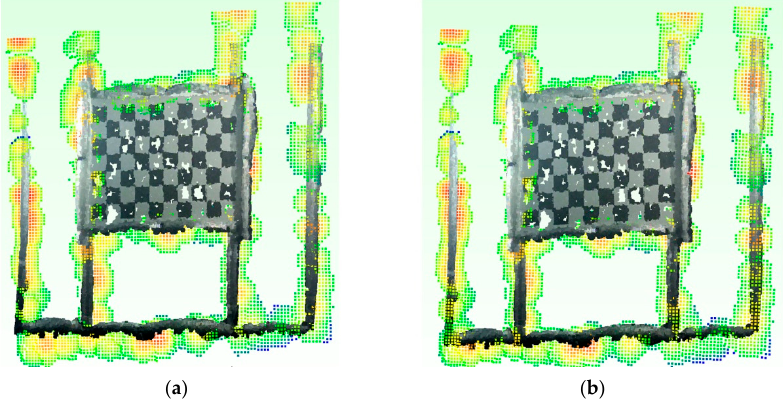
Figure 15. Optical and acoustic 3D point clouds after coarse ( a ) and fine; ( b ) registration